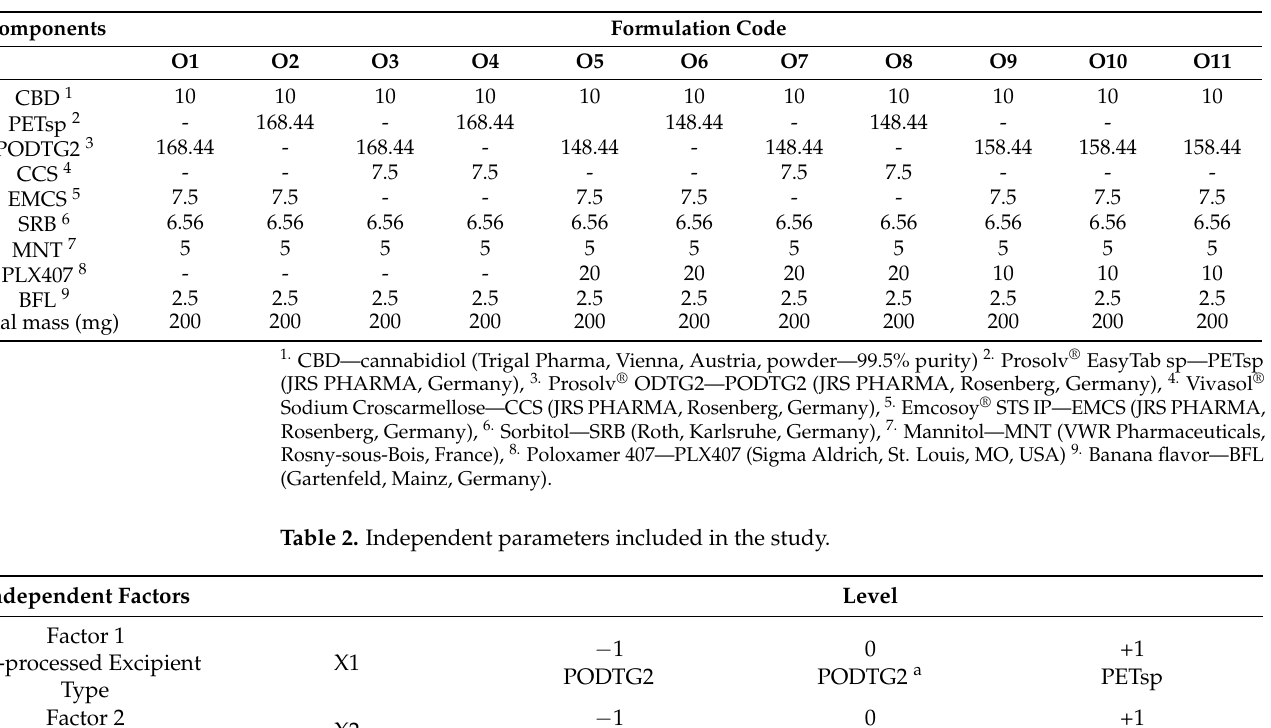
Table 1. The CBD ODTs proposed and their composition.